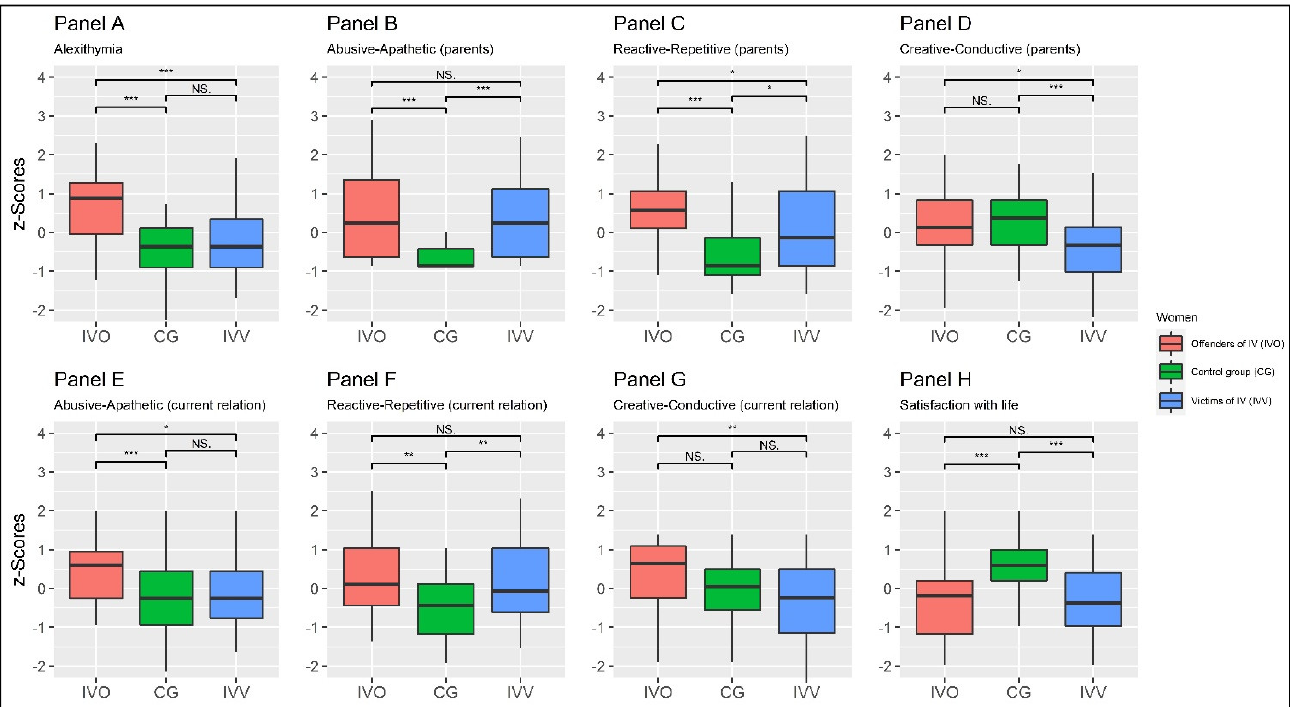
Figure 2. Plot of the between-group differences (level equality). Note: NS: p > 0.50; * p < 0.050; ** p < 0.010; *** p < 0.001;. Taking into account TAS-20, MANOVA revealed statistically significant differences between the three groups: F = 18.477, p < 0.001, and f = 0.204. Furthermore, the univariate- focused contrast between the IVO and the CG ’s means showed a statistically significant difference: t = 6.096, p < 0.001, g = |1.29|, η = 0.385. At the same time, the univariate-focused